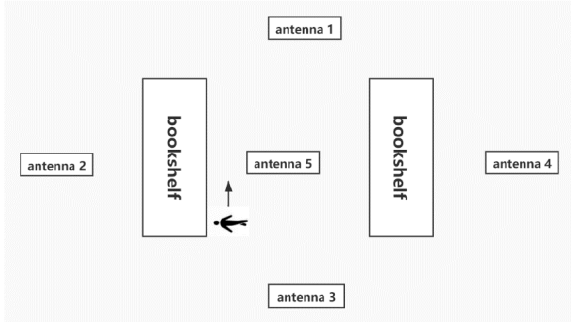
Figure 6. Experimental environment deployment.